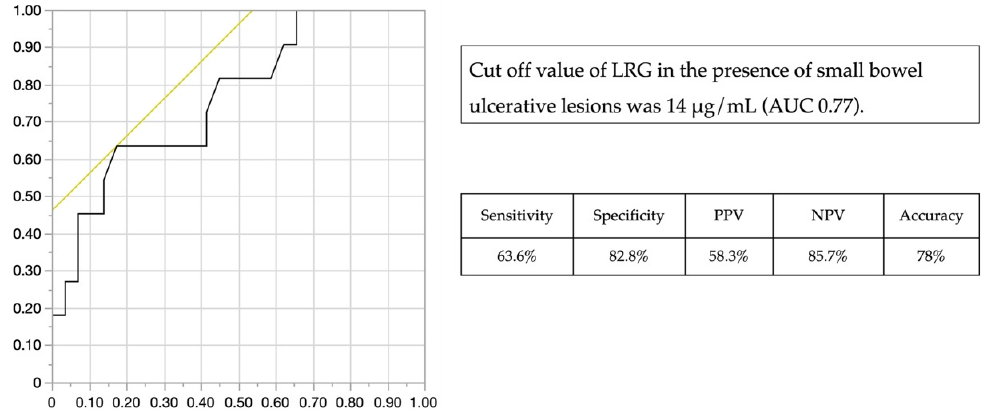
Figure 2. ROC curve of LRG for small bowel ulcerative lesion ( ≥ 0.5 cm). AUC; Area under the curve, LRG; Leucine-Rich Alpha-2 Glycoprotein, NPV: negative predictive value, PPV: positive predictive value, ROC; Receiver operating characteristic.